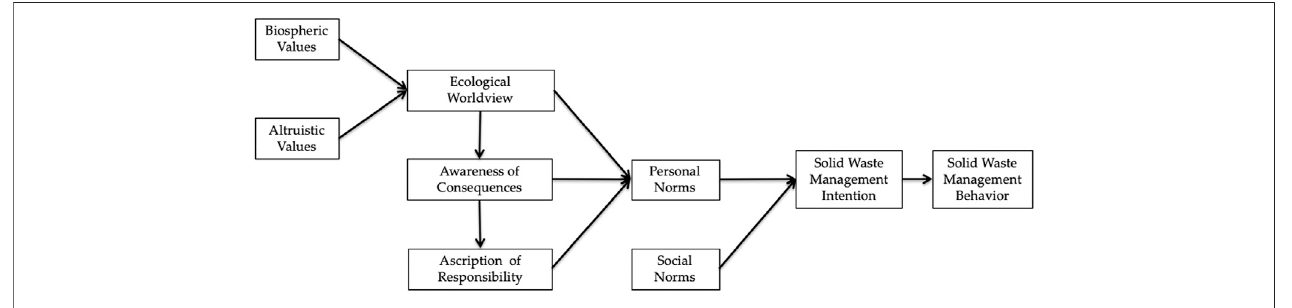
FIGURE 1 | Research